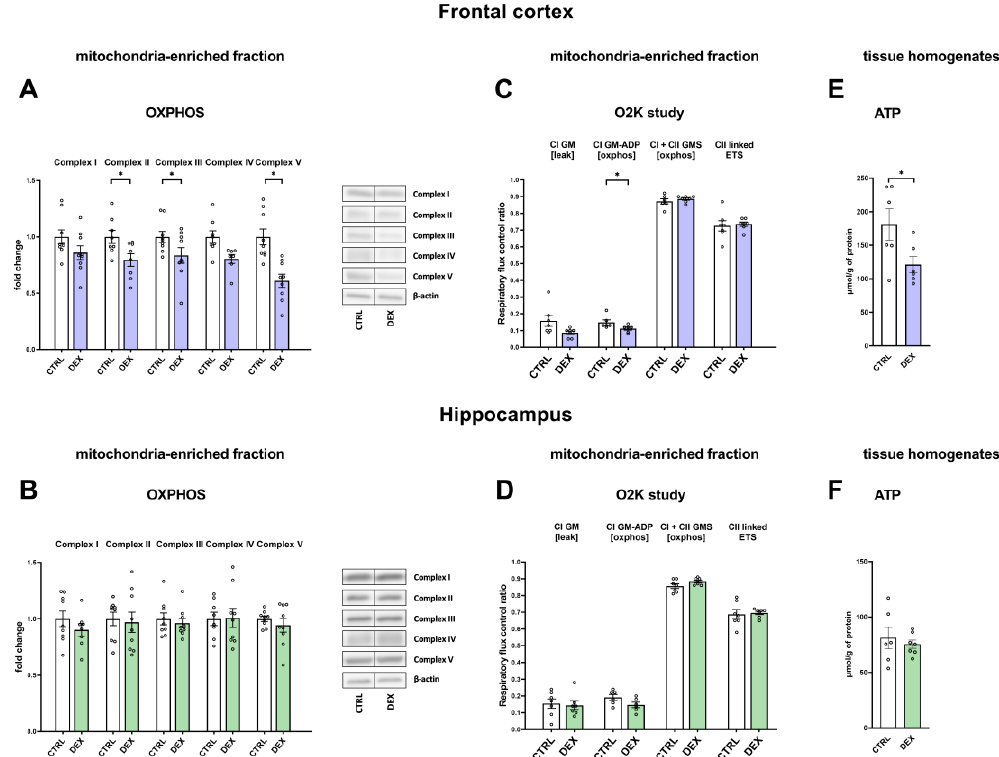
Figure 3. The effects of DEX treatment on OXPHOS levels, mitochondrial respiration capacity, and ATP levels in the mitochondria-enriched fraction/homogenates of the frontal cortex ( A , C , E ) and the hippocampus ( B , D , F ); OXPHOS levels were determined with Western blotting analysis, mitochondrial respiration capacity was determined via respirometry, and ATP level via luminescent measurements; * p < 0.05, n = 7 – 9 for OXPHOS determination, n = 6 – 7 for O2K study and for ATP level assessment. The results are expressed as the average fold change ± SEM ( A , B ) or as the mean ± SEM ( C – F ). Statistics: one-way ANOVA.